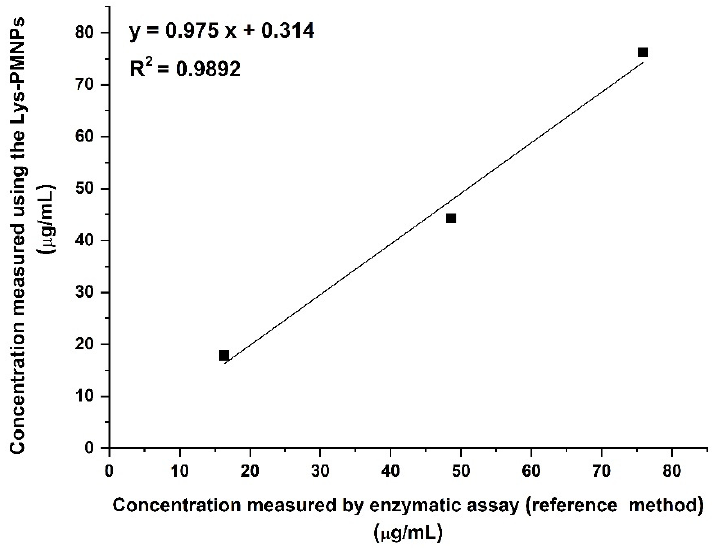
Figure 11. Concentrations of unknown urine samples measured using the Lys-PMNPs and by an enzymatic assay using Micrococcus lysodeikticus cells.